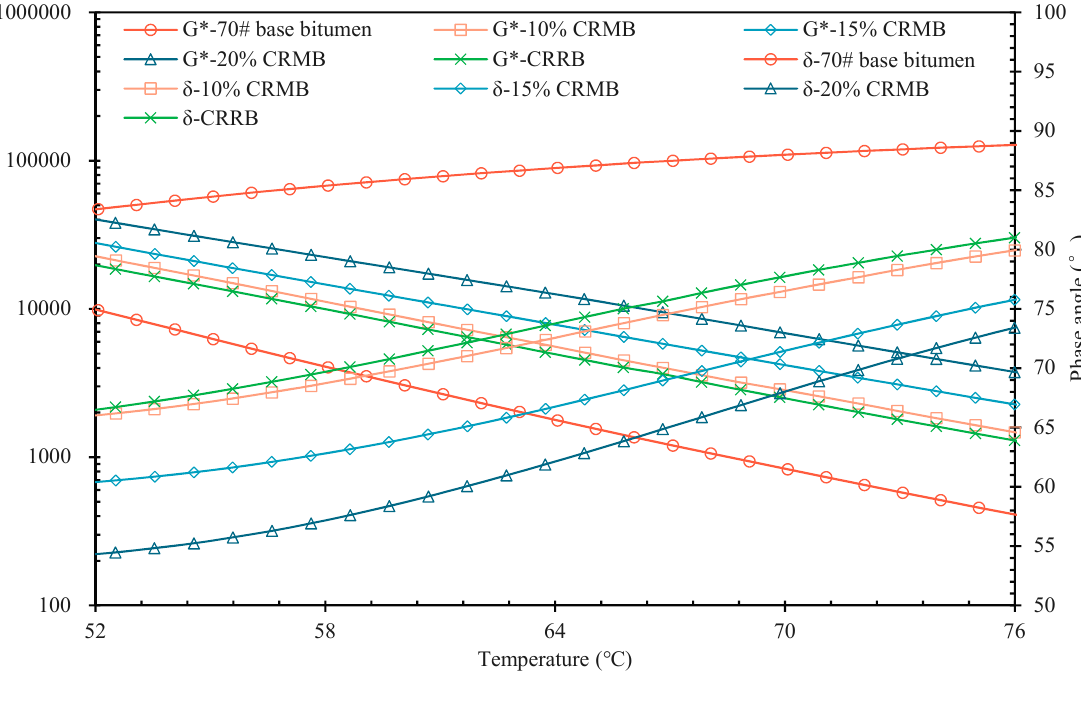
Figure 4. G* and δ curve.